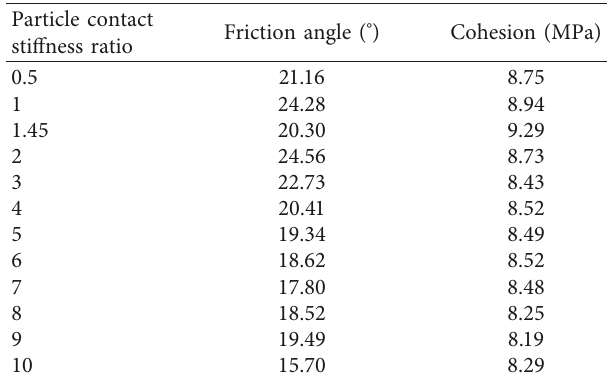
Table 1: Shear strength parameter values of different particle contact stiffness ratio.